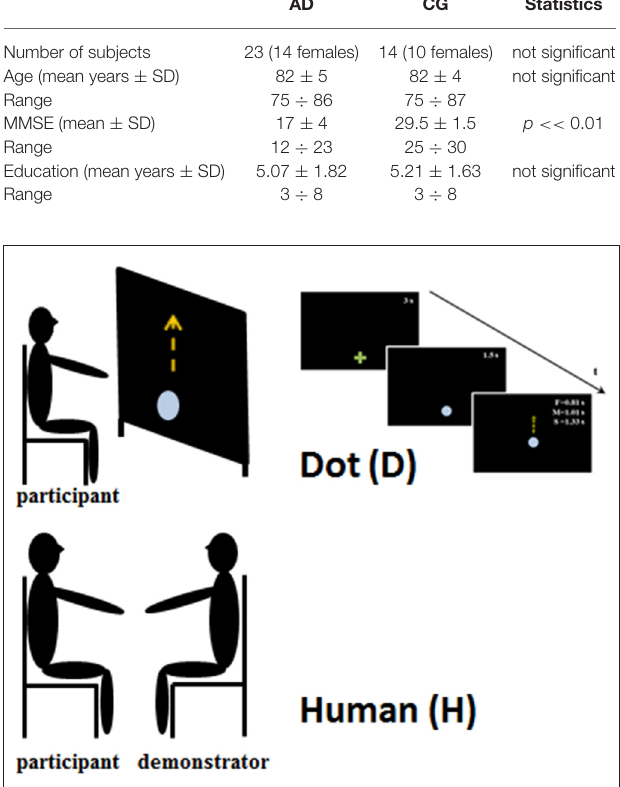
FIGURE 1 | Experimental set-up. The upper part of the figure represents the set-up when the participants observed the Dot stimulus. They were seated in front of a large screen and they observed the upward displacement of the Dot at three different speeds and durations: slow—S 1.33 s; medium—M 1.01 s; and fast—F 0.81 s. The bottom part of the figure shows the experimental set-up for the human obsevation condition, in which the participants and human demonstrator were seated face to face. In both conditions participants were requested to observe the stimulus movements and when the stimulus stoped to reach its/his final position, imitating its/his